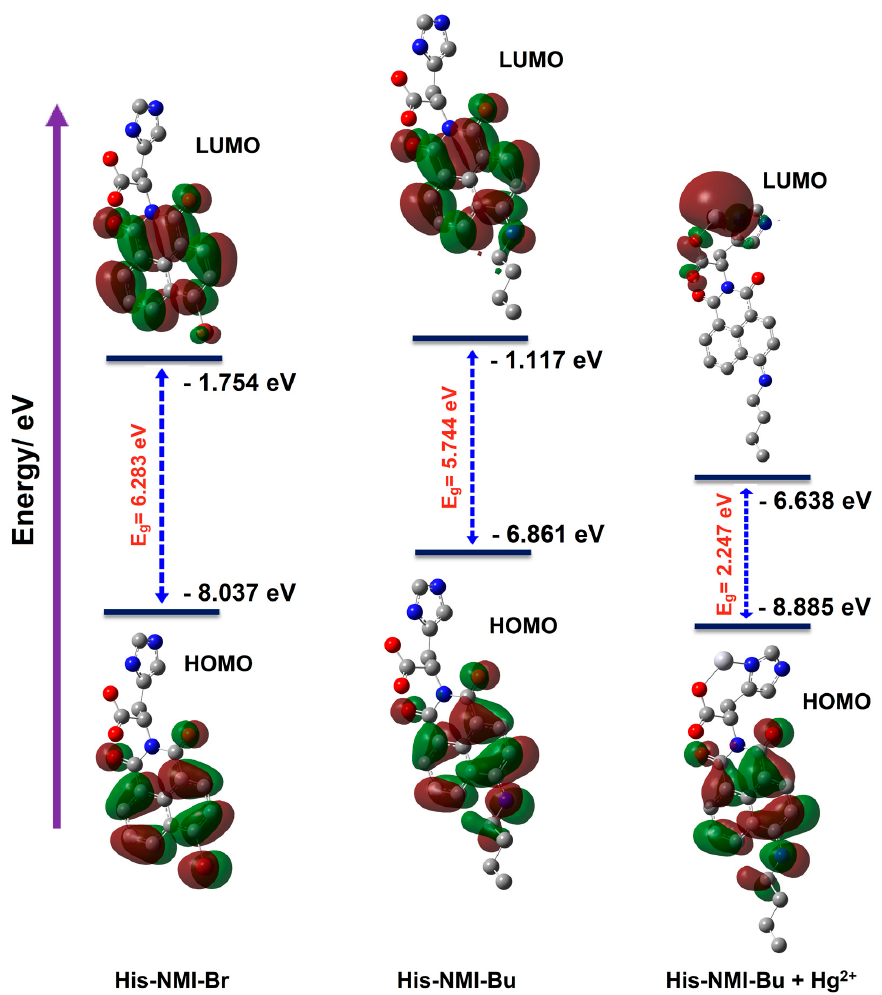
Figure 2. Schematic diagram illustrating the FMOs distribution and band gap energy for His-NMI-Br , His-NMI-Bu, and His-NMI-Bu + Hg 2+ complex.